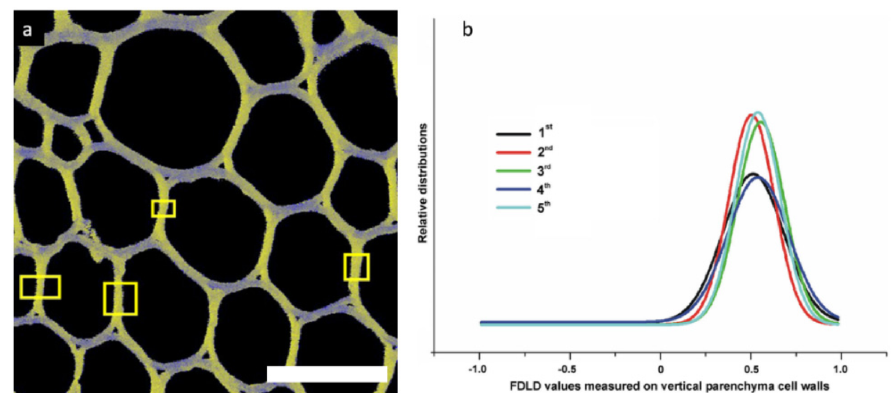
Figure 9. ( a ) Example of DP-LSM image (3rd internode, straight), with marked yellow rectangles presenting parts of cell walls used for FDLD analyses. Bar is 20 µ m. ( b ) Gaussian fits of FDLD distributions in D. balcanica parenchyma cell walls of straight (1st–4th) and twisted (5th) internodes. (Composed from figures published in [52], with permission from Springer Nature).